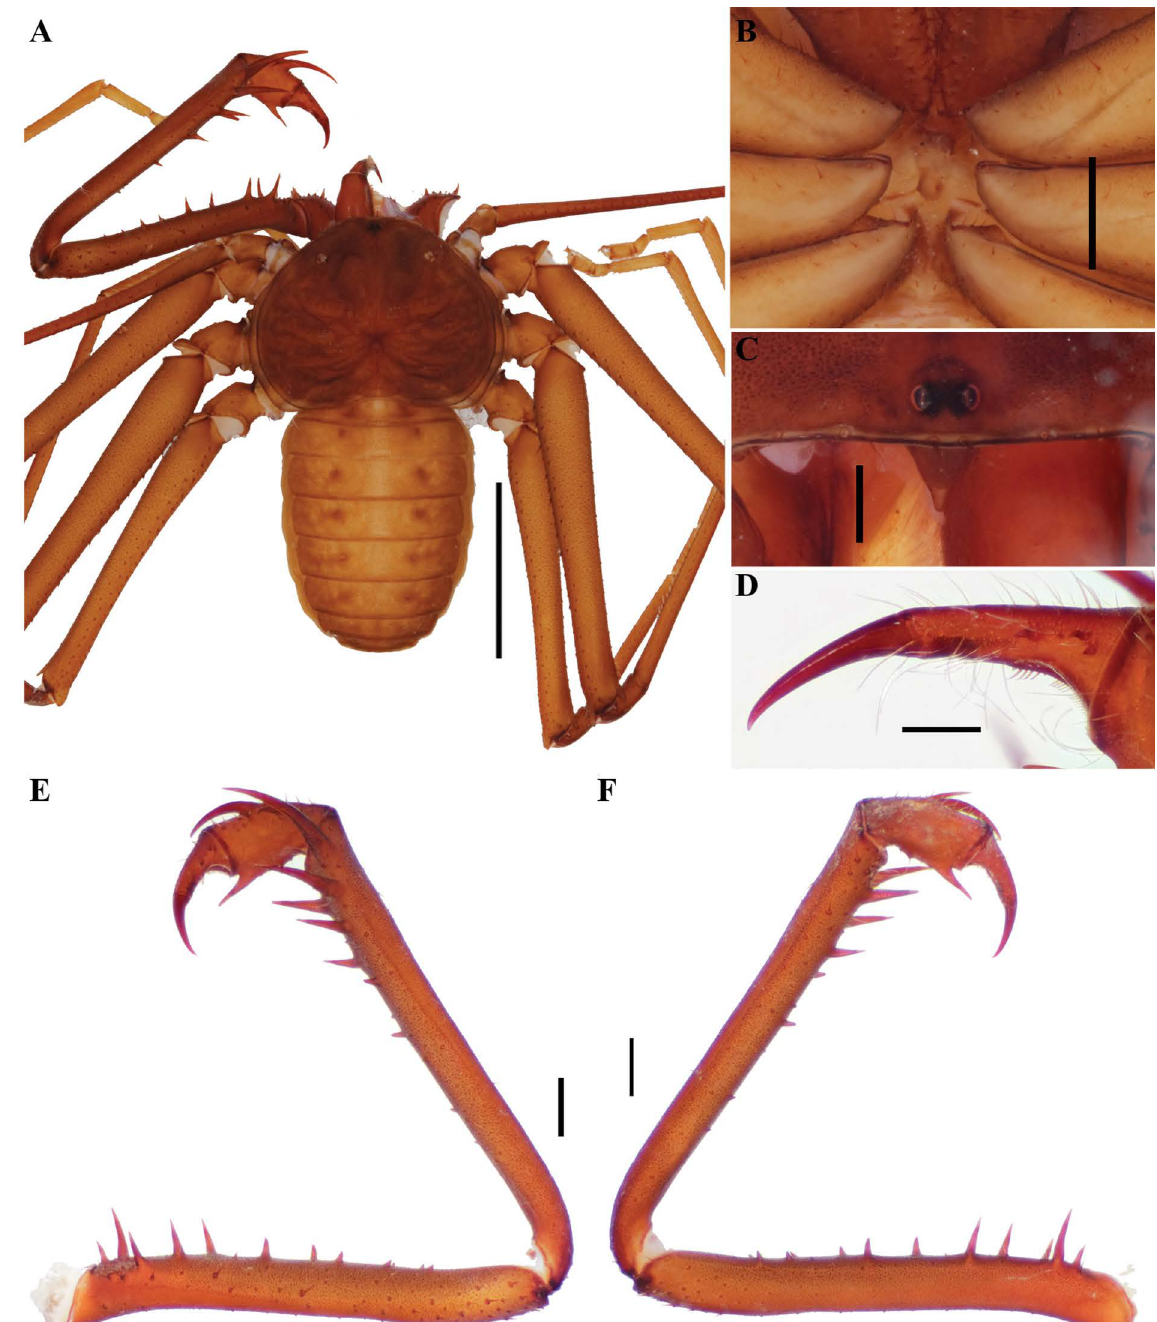
Fig. 64. Charinus goitaca sp. nov. (MNRJ 9224), general morphology, ♂. A . Habitus, dorsal view. B . Sternum, ventral view. C . Frontal process. D . Pedipalp tarsus, frontal view. E . Pedipalp, dorsal view. F . Pedipalp, ventral view. Scale bars: A = 0.5 cm; B, E–F = 1 mm; C–D = 0.5